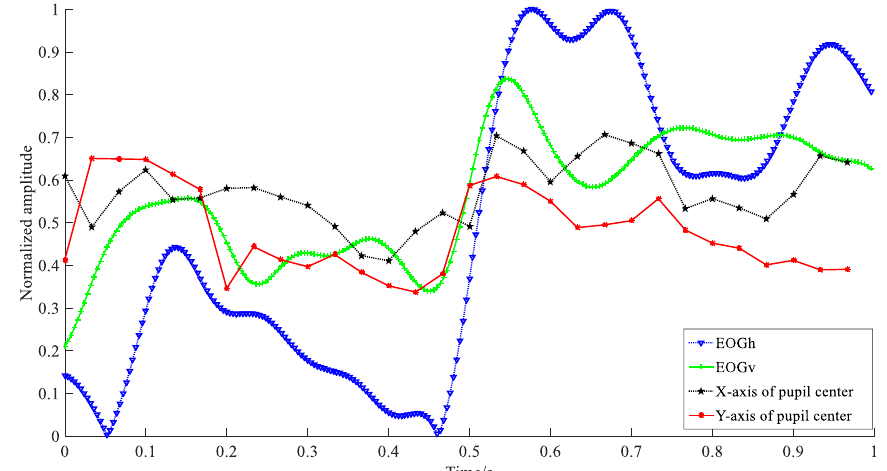
Figure 8. Waveforms of normalized EOG and video signals according to the horizontal and vertical eye movements, receptively. EOG h and video eye movement in X -axis indicate the horizontal eye movement components, EOG v and Y- axis are the vertical eye movement components.